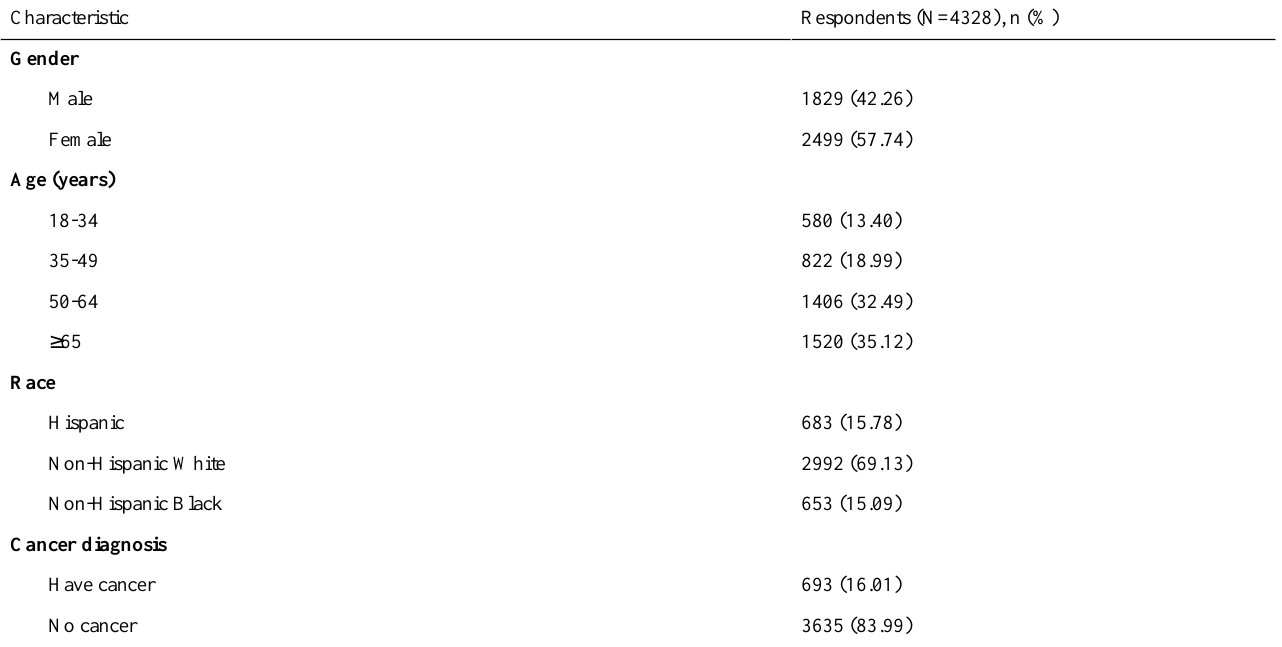
Table 2. Demographic characteristics of the